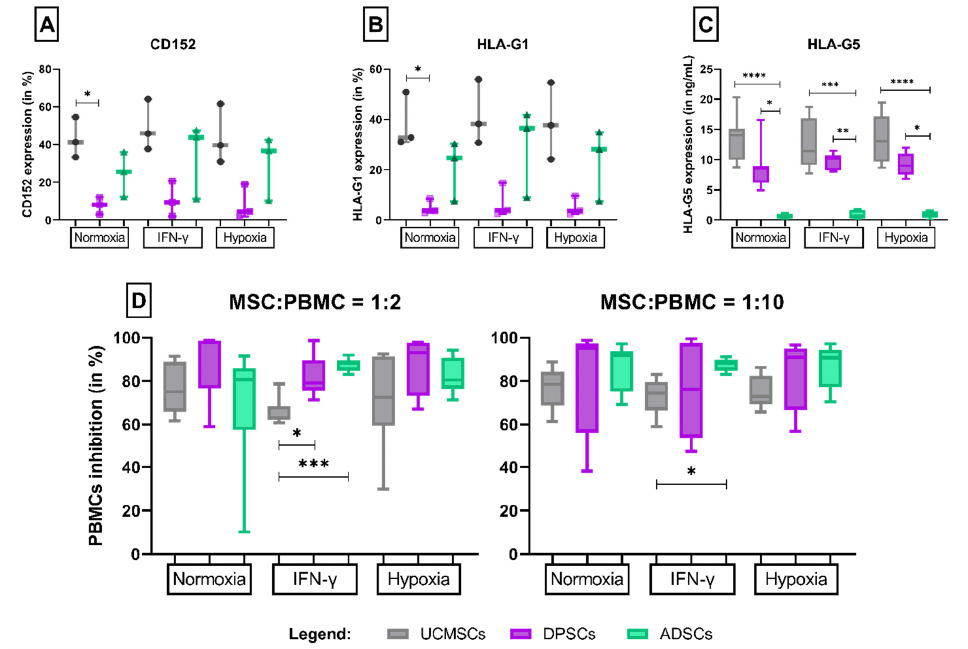
Figure 3. Inhibitory profile of MSCs cultured in standard medium, stimulated with IFN- γ , or under hypoxic conditions. Legend: Differential expression of ( A ) CD152, ( B ) HLA-G1 membrane isoform and ( C ) HLA-G5 soluble isoform between sources of MSCs cultured in different culture con- ditions; ( D ) ability to inhibit the proliferation of immune cells by MSCs in different culture condi- tions with the proportion MSCs:PBMCs 1:2 and 1:10. p values: (*) ≤ 0.05; (**) ≤ 0.01; (***) ≤ 0.001; (****) ≤ 0.0001. UCMSCs = umbilical cord mesenchymal stromal cells; DPSCs = dental pulp stromal cells; ADSCs = adipose tissue-derived stromal cells; INF-y = interferon-gamma; MSCs = mesenchymal stromal cells; PBMCs = peripheral blood mononuclear